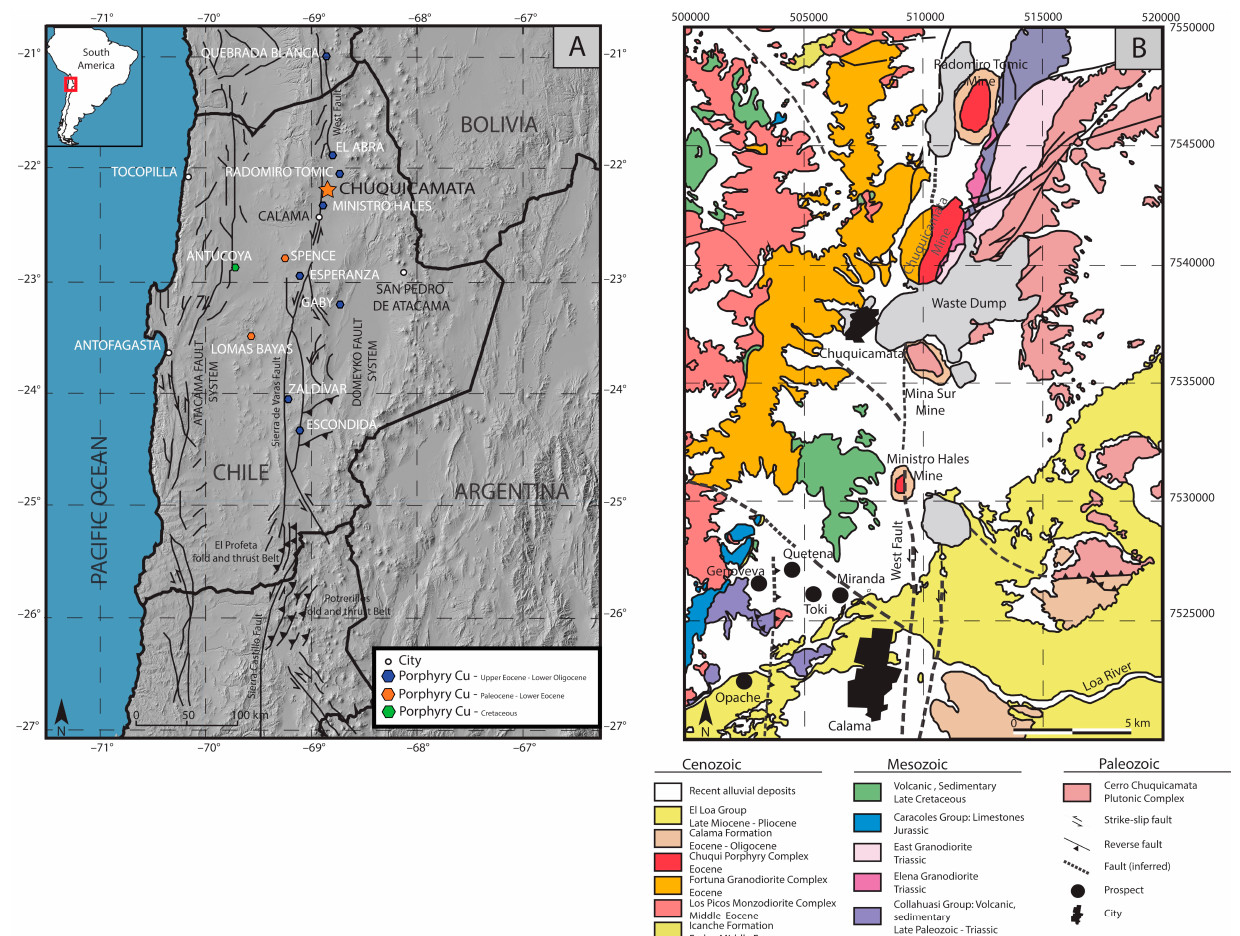
Figure 1. ( A ) Location of the Chuquicamata porphyry Cu-Mo deposit in relation to other deposits in the Antofagasta region, northern Chile. ( B ) Geological map of the Chuquicamata district. Modified from